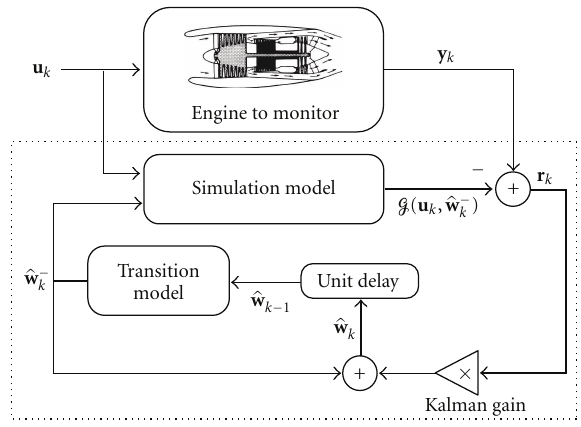
Figure 2: Health parameter update mechanism using an extended Kalman